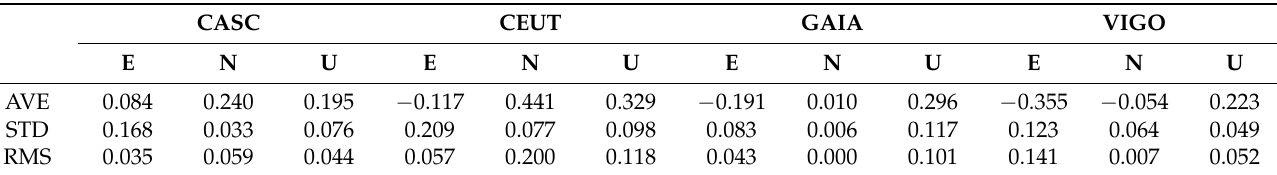
Table 14. Statistics results from the Test